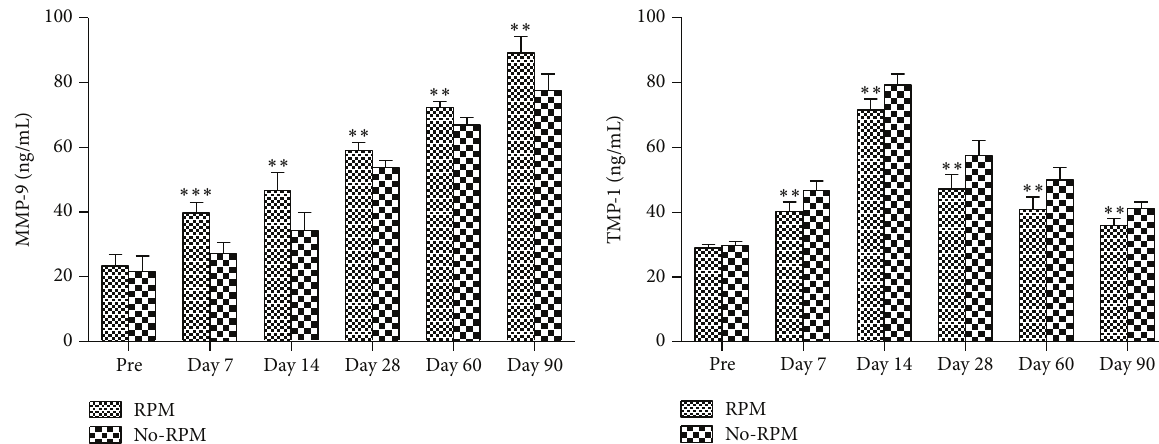
Figure 4: Aqueous humor levels of MMP-9 and TIMP-1 in Boston Type 1 keratoprosthesis (KPro) implanted rabbits with or without RPM formation. Pre: preoperation; Day: postoperative day; RPM: retroprosthetic membrane. ∗∗ 𝑝 < 0.01 , ∗∗∗ 𝑝 < 0.001 versus the No-RPM group.